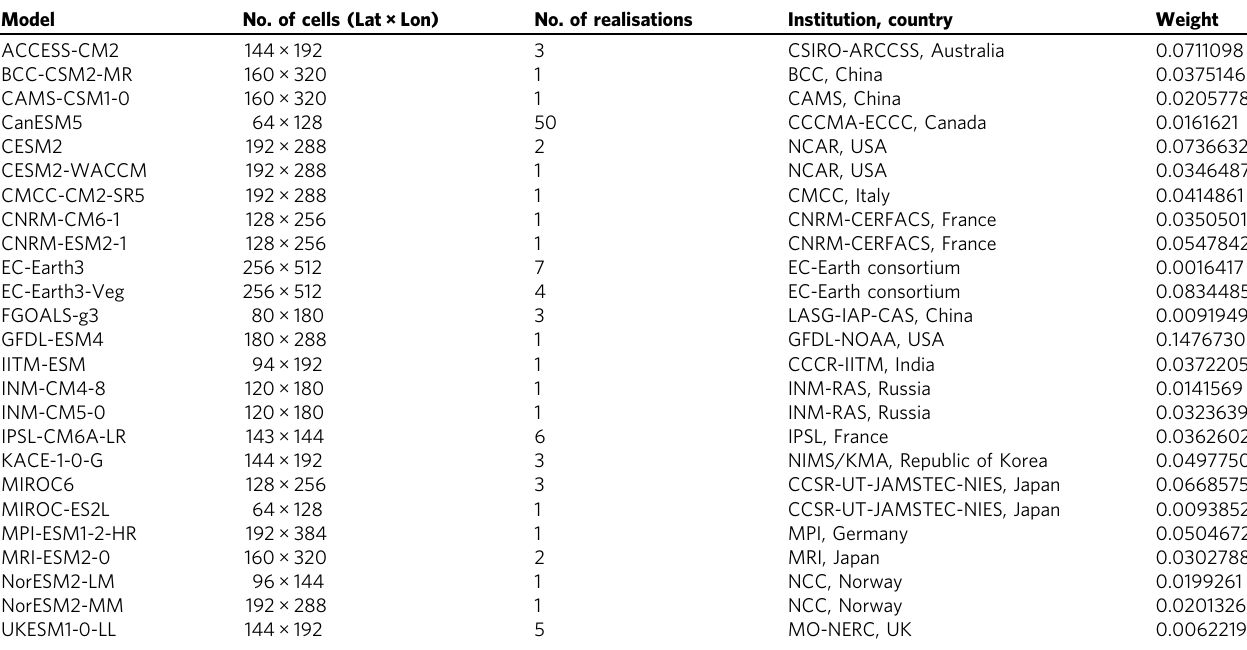
Table 1 Overview of the CMIP6 GCMs and the weights for each GCM included in this study.